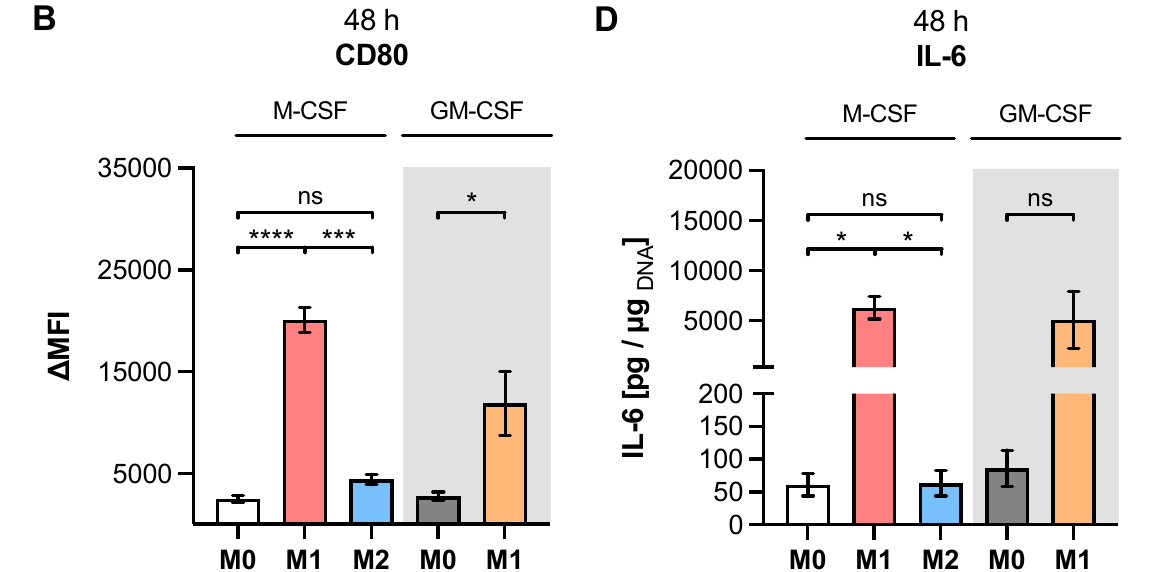
Figure A2. Flow cytometric analysis of macrophage surface markers 8 days after differentiation. Negatively selected monocytes were differentiated to macrophages using M-CSF or GM-CSF (highlighted in grey). After 6 days, M Φ were stimulated with IFN- γ /LPS (M1), IL-4 (M2), or with no additive (M0), for 48 h. The surface expressions (n, sample = 3) of ( A ) CD163, ( B ) CD80 and ( C ) CD206 were determined using flow cytometry. The arithmetic mean fluorescence intensity (MFI) was measured for the markers, and the MFI of unstained cells was subtracted ( ∆ MFI). ( D ) Quantification of IL-6 (n, sample = 3; n, biological = 2) released by M Φ was determined from the cell culture supernatants via immunoassay, and referred to the respective DNA content of the corresponding cell lysates. All data shown were analyzed using a one-way ANOVA, followed by Tukey’s multiple comparison tests, and expressed as mean ± SEM. ns (not significant), p < 0.05 (*), p < 0.01 (**), p < 0.001 (***), p < 0.0001 (****).